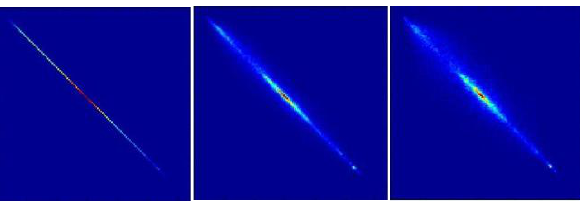
Figure 1. Joint distribution of same-sensor images, registered (left) and misregistered by 5 pixels (middle) and 10 pixels (right)